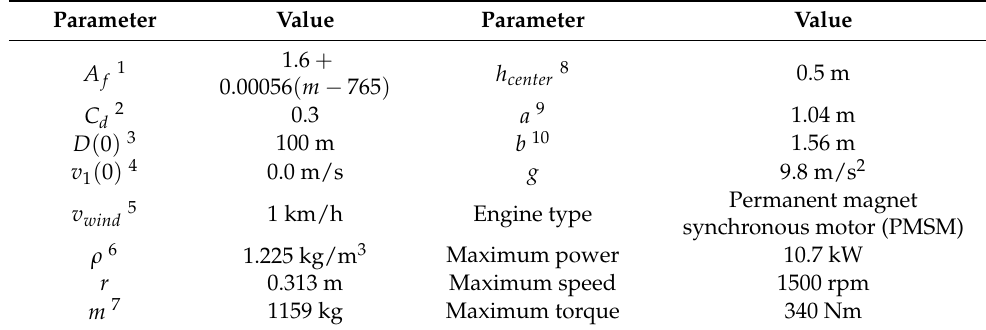
Table 2. Vehicle dynamics